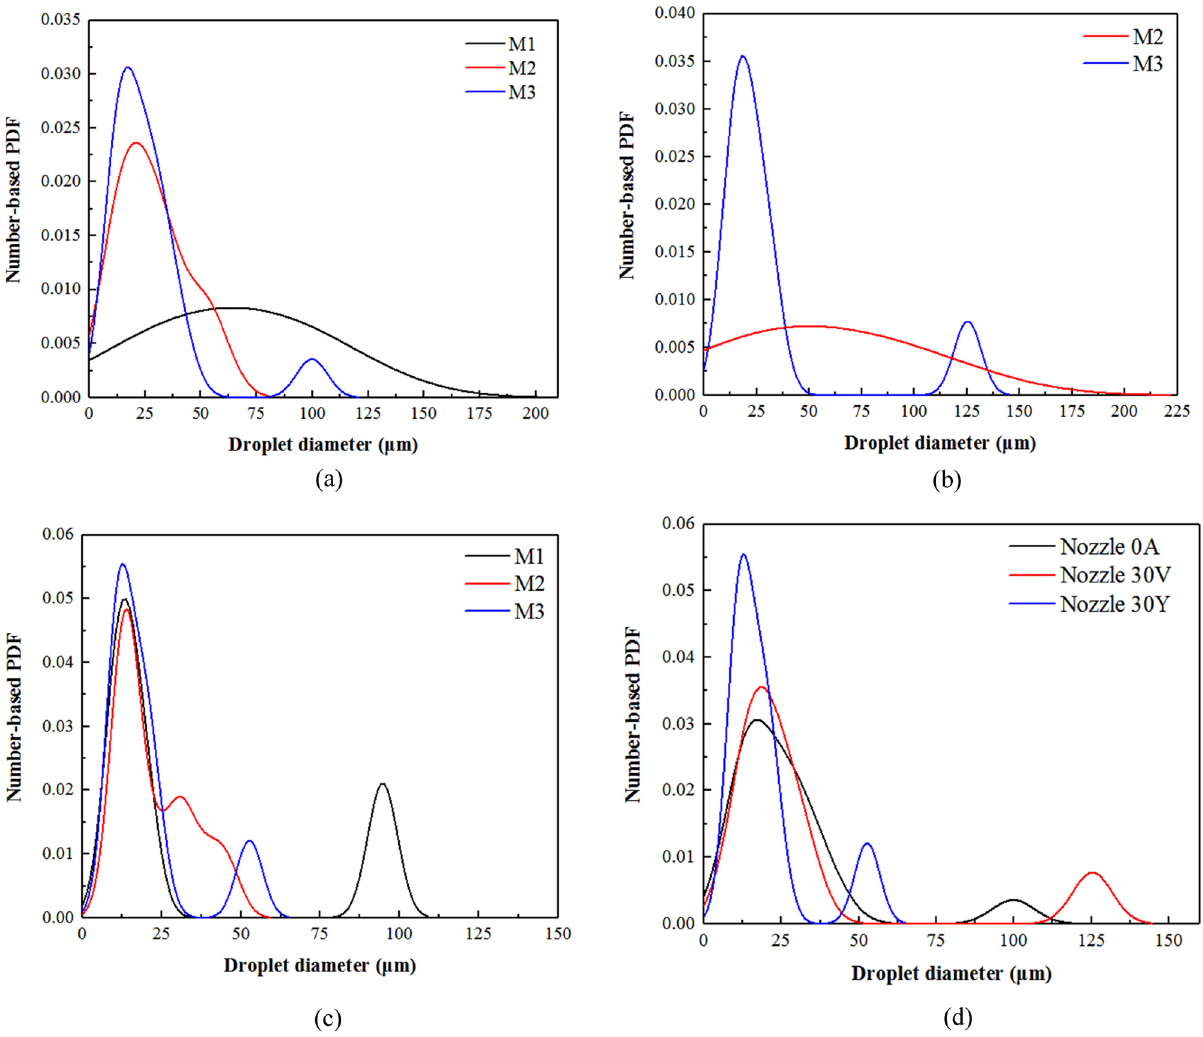
Figure 14: Droplet size distribution at di ff erent locations downstream of the nozzles. The droplet size distribution of the ( a ) 0A nozzle, ( b ) 30V nozzle, ( c ) 30Y nozzle; and ( d ) at